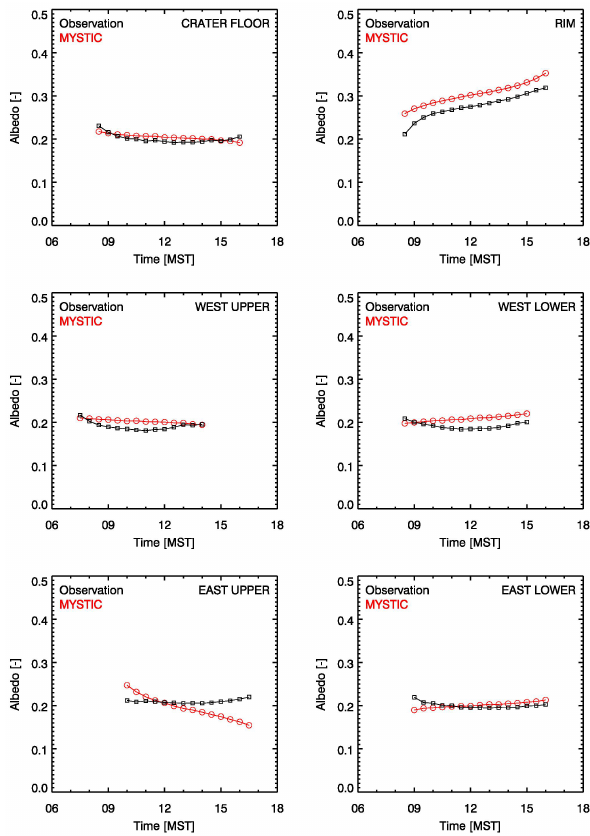
Fig. 7. Observed (black) and modeled (red) slope-parallel short- wave reflected radiation at the six crater sites for 21 October 2006.